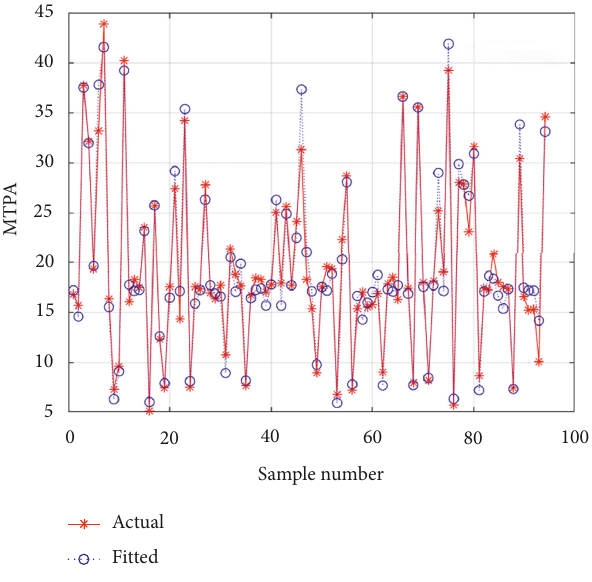
Figure 6: SVR model prediction